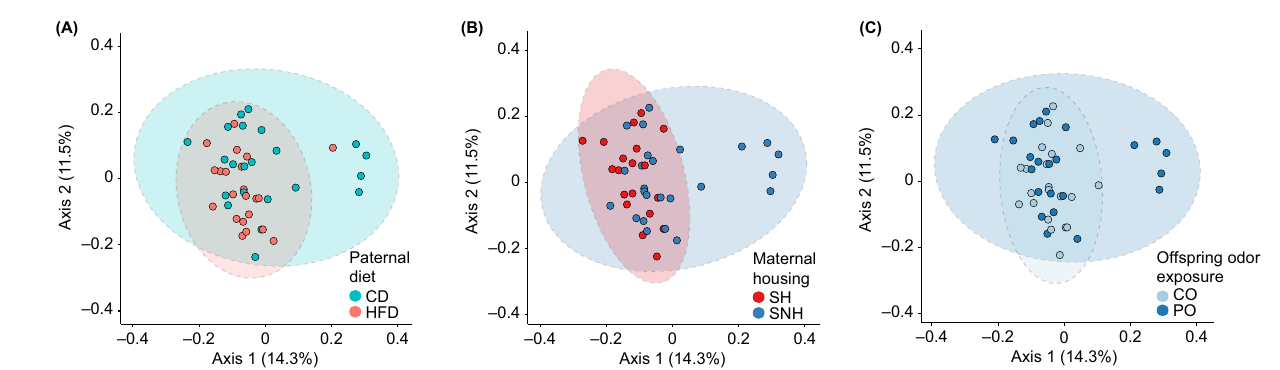
Figure 4. Emperor plots of unweighted unique fraction metric (UniFrac) distances and principal coordinates analyses (PCoA) demonstrate that between-subjects beta diversities differ among F 1 offspring depending on paternal F 0 conditions, maternal housing conditions, and stress exposure. PCoA axes 1 and 2 explain 25.8% of the variation shown here among samples grouped by ( A ) paternal diet (blue = control diet, CD; orange = high-fat diet, HFD), ( B ) maternal housing conditions (red = standard housing, SH; dark blue = semi-naturalistic housing, SNH), and ( C ) stress in the predator odor exposure (OE) test on postnatal day 42 (PD42) (light blue = control odor, CO; dark blue = predator odor, PO). Each sample is represented as a single point in principal coordinate space; points that are closer together are more similar than those that are further apart. Dashed ellipses represent 95% confidence intervals around the centroid mean and are filled with the color corresponding to each group. OE odor exposure, PCoA principal coordinates analyses, PD postnatal day, SH standard housing, SNH semi- naturalistic